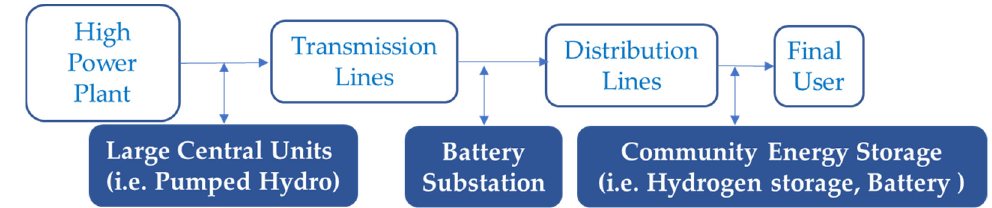
Figure 1. Conventional path of utility energy storage.